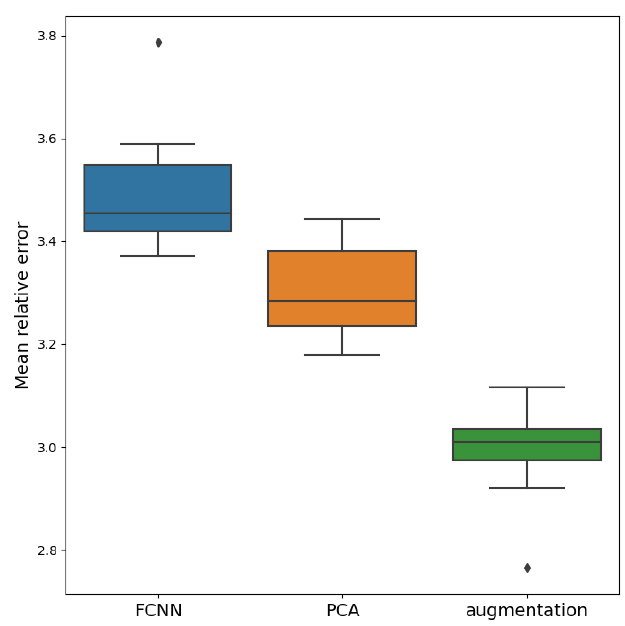
Figure 5. Distribution of mean relative percentage errors for 3 models: baseline model, model trained on PCA features and model trained on augmented